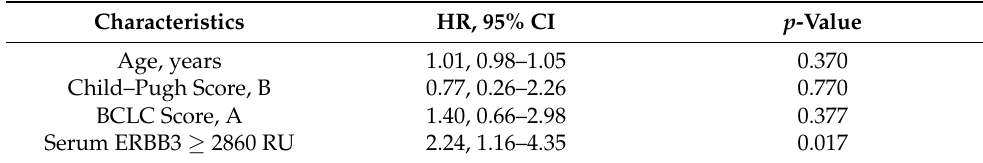
Table 2. Multivariate Cox proportional-hazard regression analysis of the predictors of overall survival